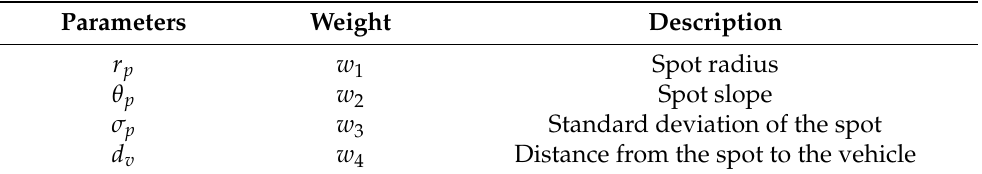
Table 2. The parameters that are analyzed to classify the spot.